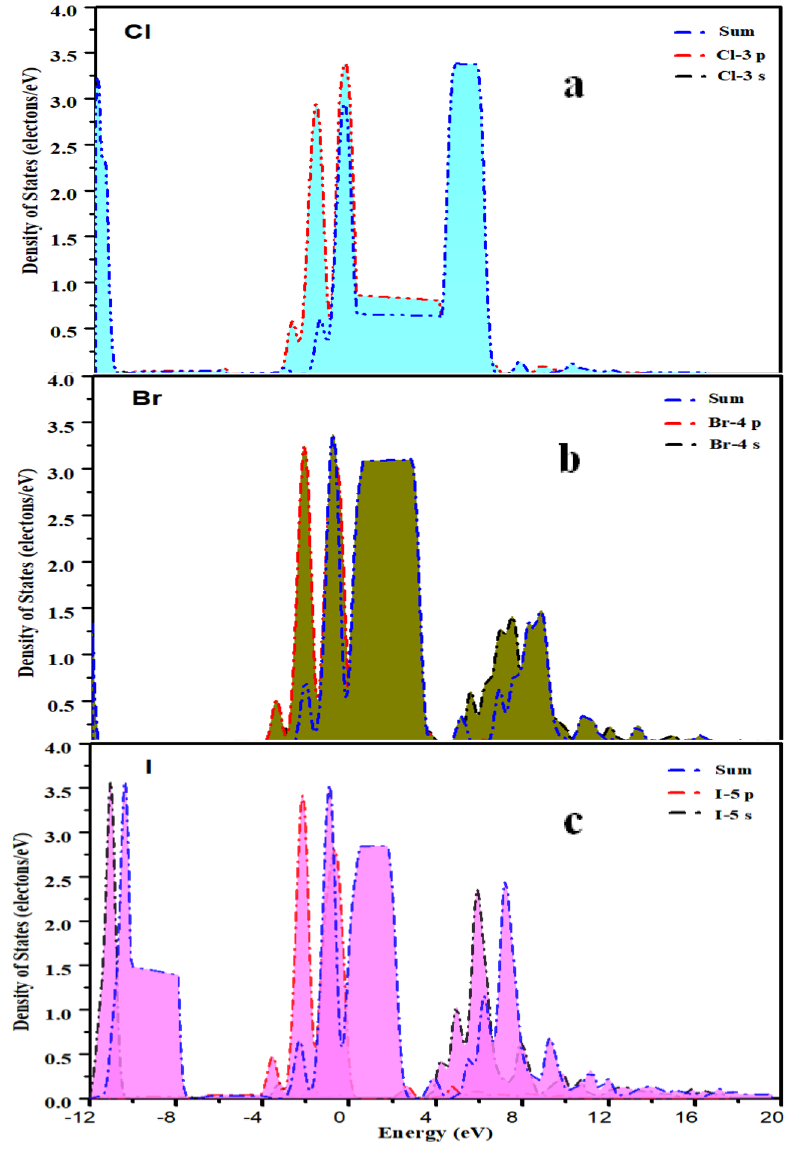
Figure 11. ( a – c ) show the PDOS curve of Halogen element chlorine (Cl), bromine (Br), iodine (I)